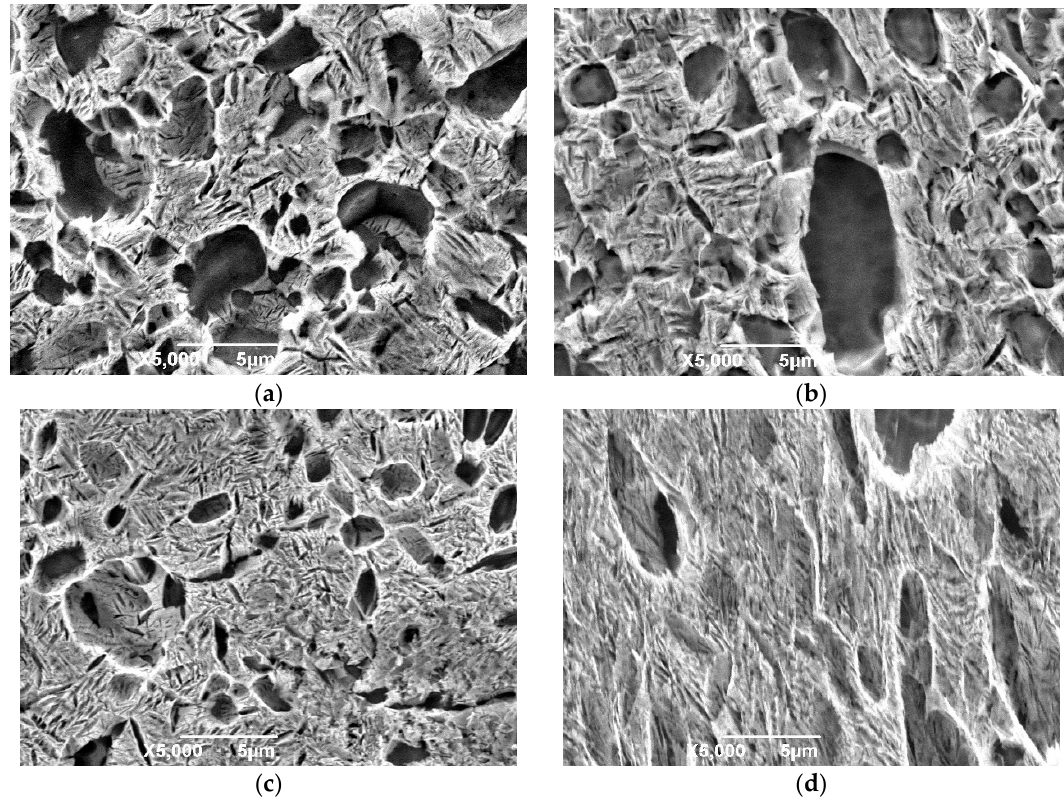
Figure 8. Microstructures of the deformed and undeformed parts in tensile samples under the different strain rates with deformation temperatures of 700 °C, ( a ) microstructure of the undeformed parts at the strain rate of 0.001 s − 1 ; ( b ) microstructure of the deformed parts at the strain rate of 0.001 s − 1 ; ( c ) microstructure of the undeformed parts at the strain rate of 0.1 s − 1 ; ( d ) the microstructure of the deformed parts at the strain rate of 0.1 s − 1 .